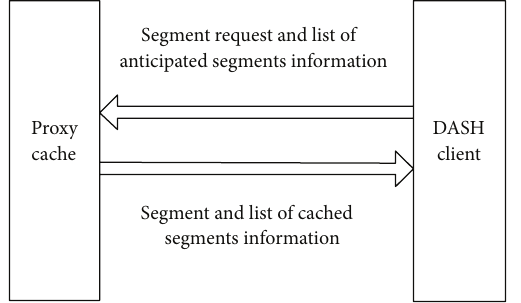
Figure 2: System architecture for DASH assisted with CLICRA- aware